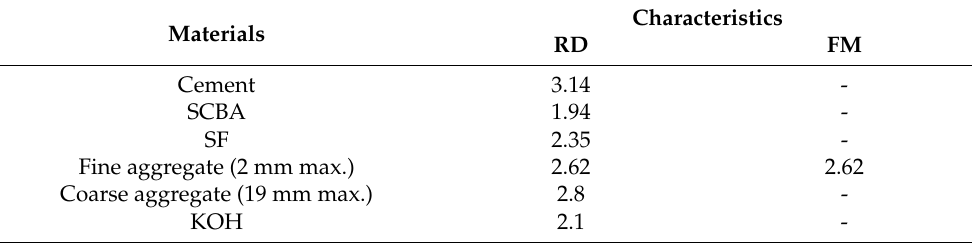
Table 1. Materials and